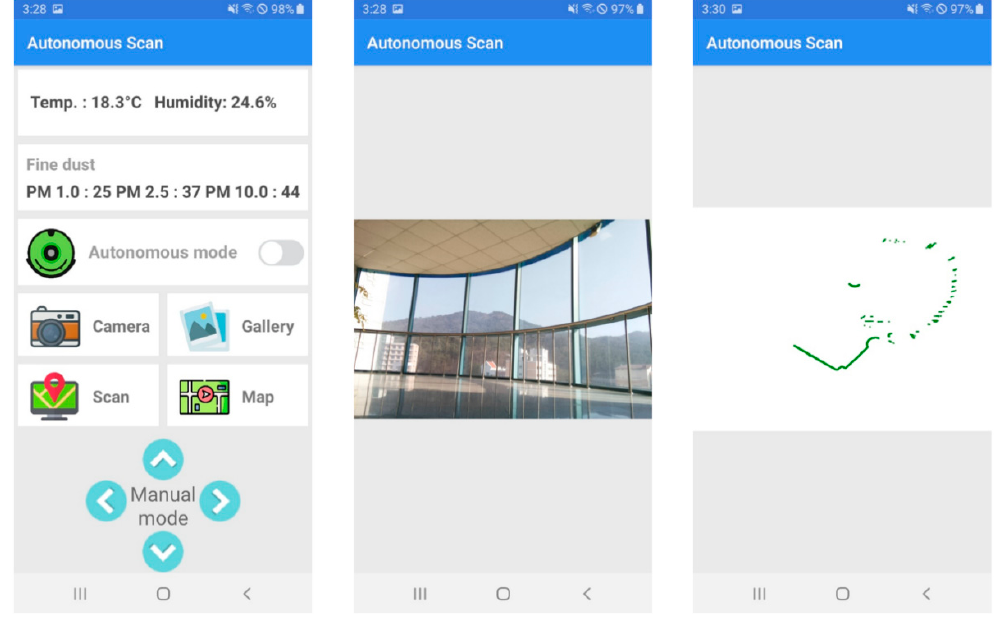
Figure 10. Environmental data result ( left ), captured image ( middle ) and scanned result ( right ) at initial position in lobby.